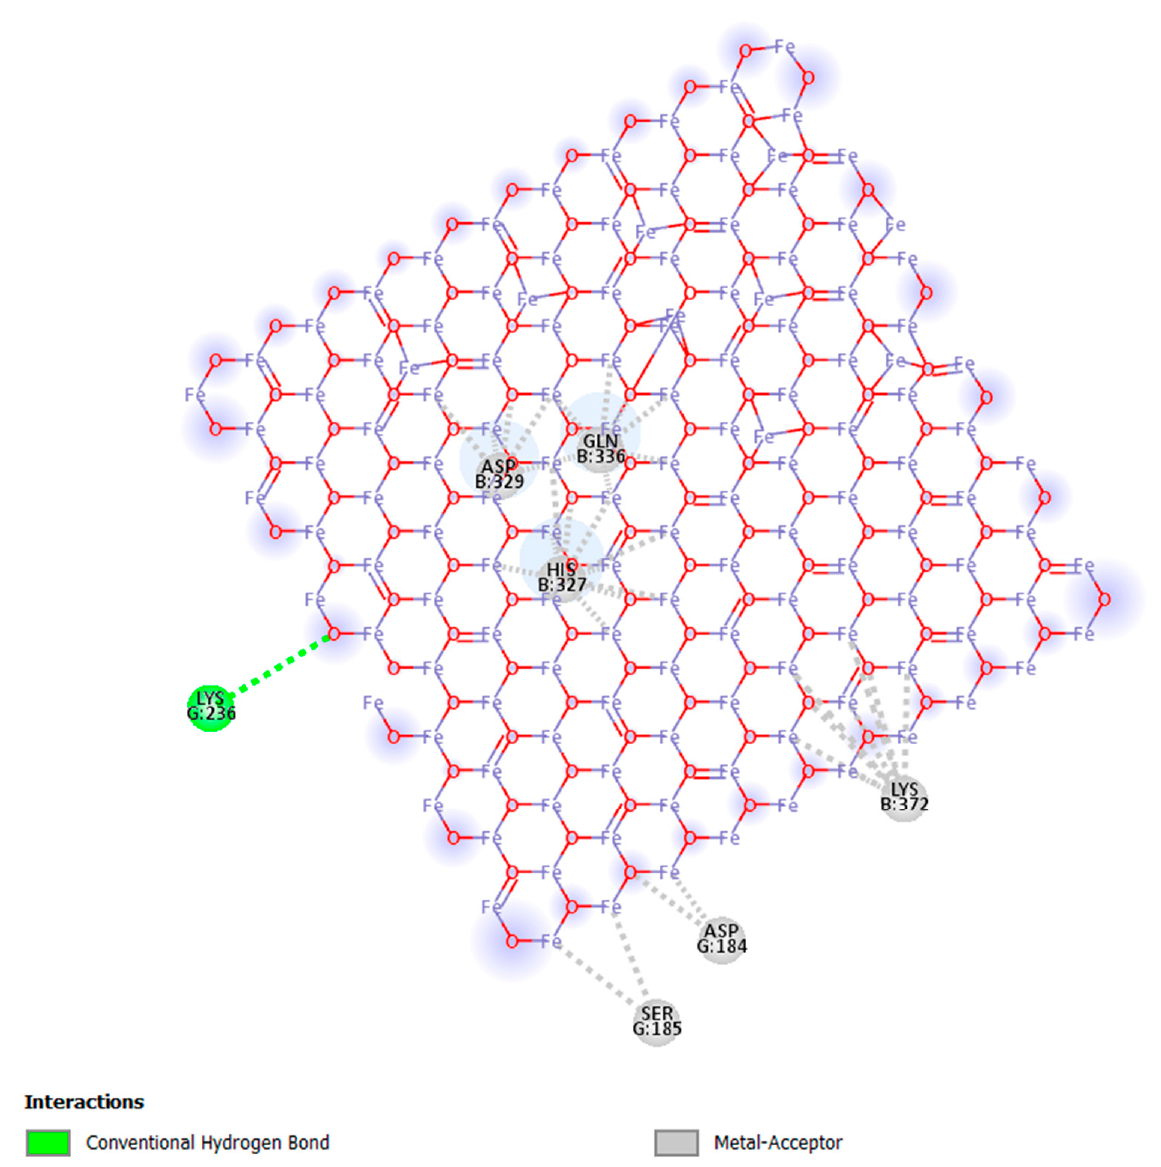
Figure A3. Two-dimensional (2D) diagram showing interactions of hemoglobin HbF with bare magnetite nanoparticle slab in the first binding pose.